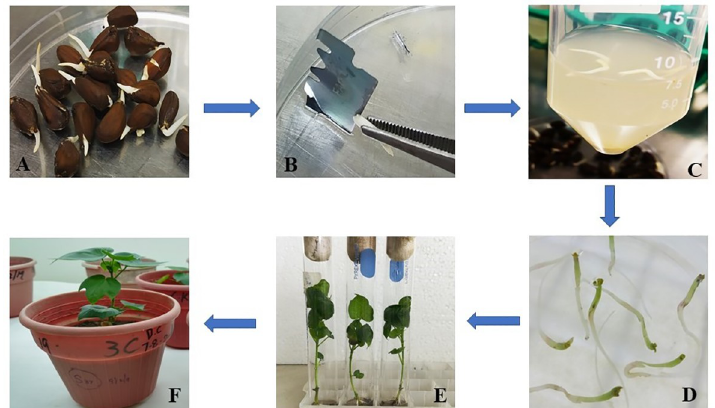
Fig 4. A: Germinated seeds, B: Injuring the embryos with sharp blade on shoot apex side, C: Co-cultivation of embryos with agrobacterium, D: Embryos in growth medium, E: plants in rooting and shooting media, F: Plants in soil pots for